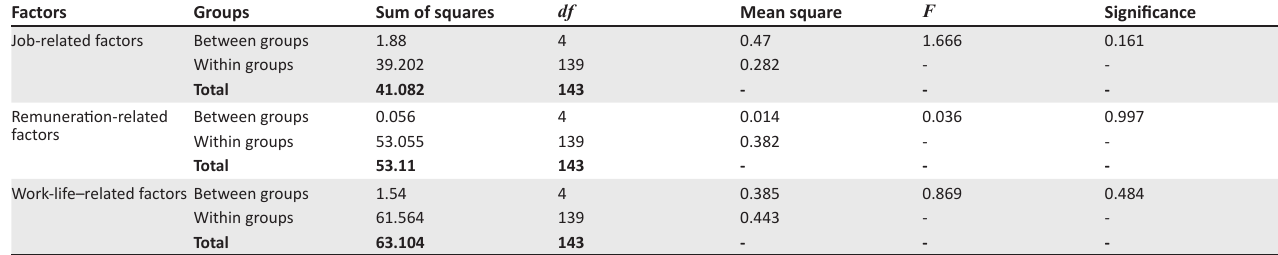
TABLE 9: Analysis of variance: Race